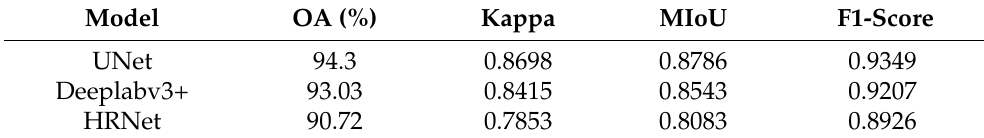
Table 10. Extraction accuracies for impervious surfaces after adding the OSM road network data.